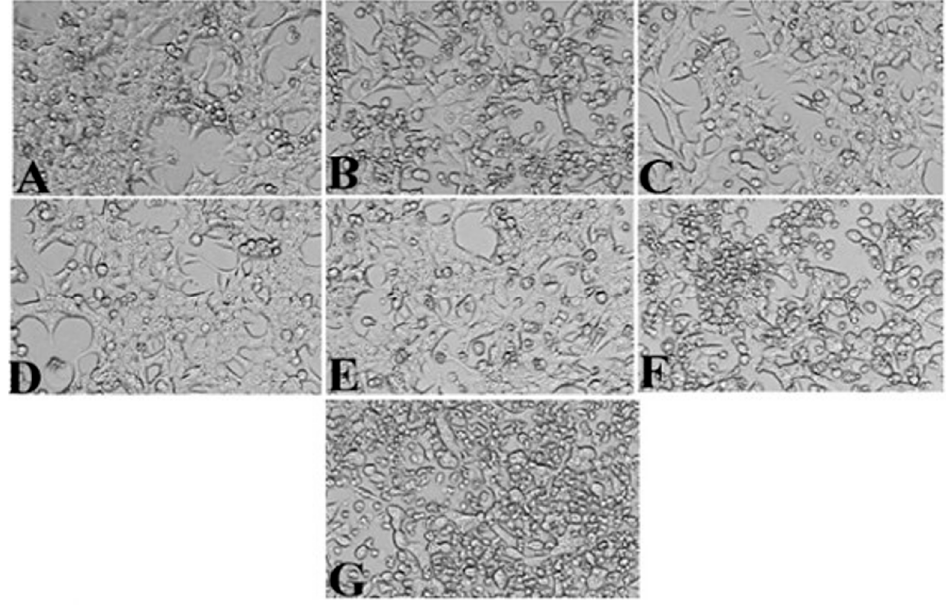
Figure 5. In vitro anticancer activity of root extract of Saussurea lappa (( A )—untreated, ( B )—positive control, ( C )—12.5 μ g/mL, ( D )—25 μ g/mL, ( E )—50 μ g/mL, ( F )—100 μ g/mL, ( G )—200 μ g/mL). (the images were captured at 10× magnification by inverted biological microscope).